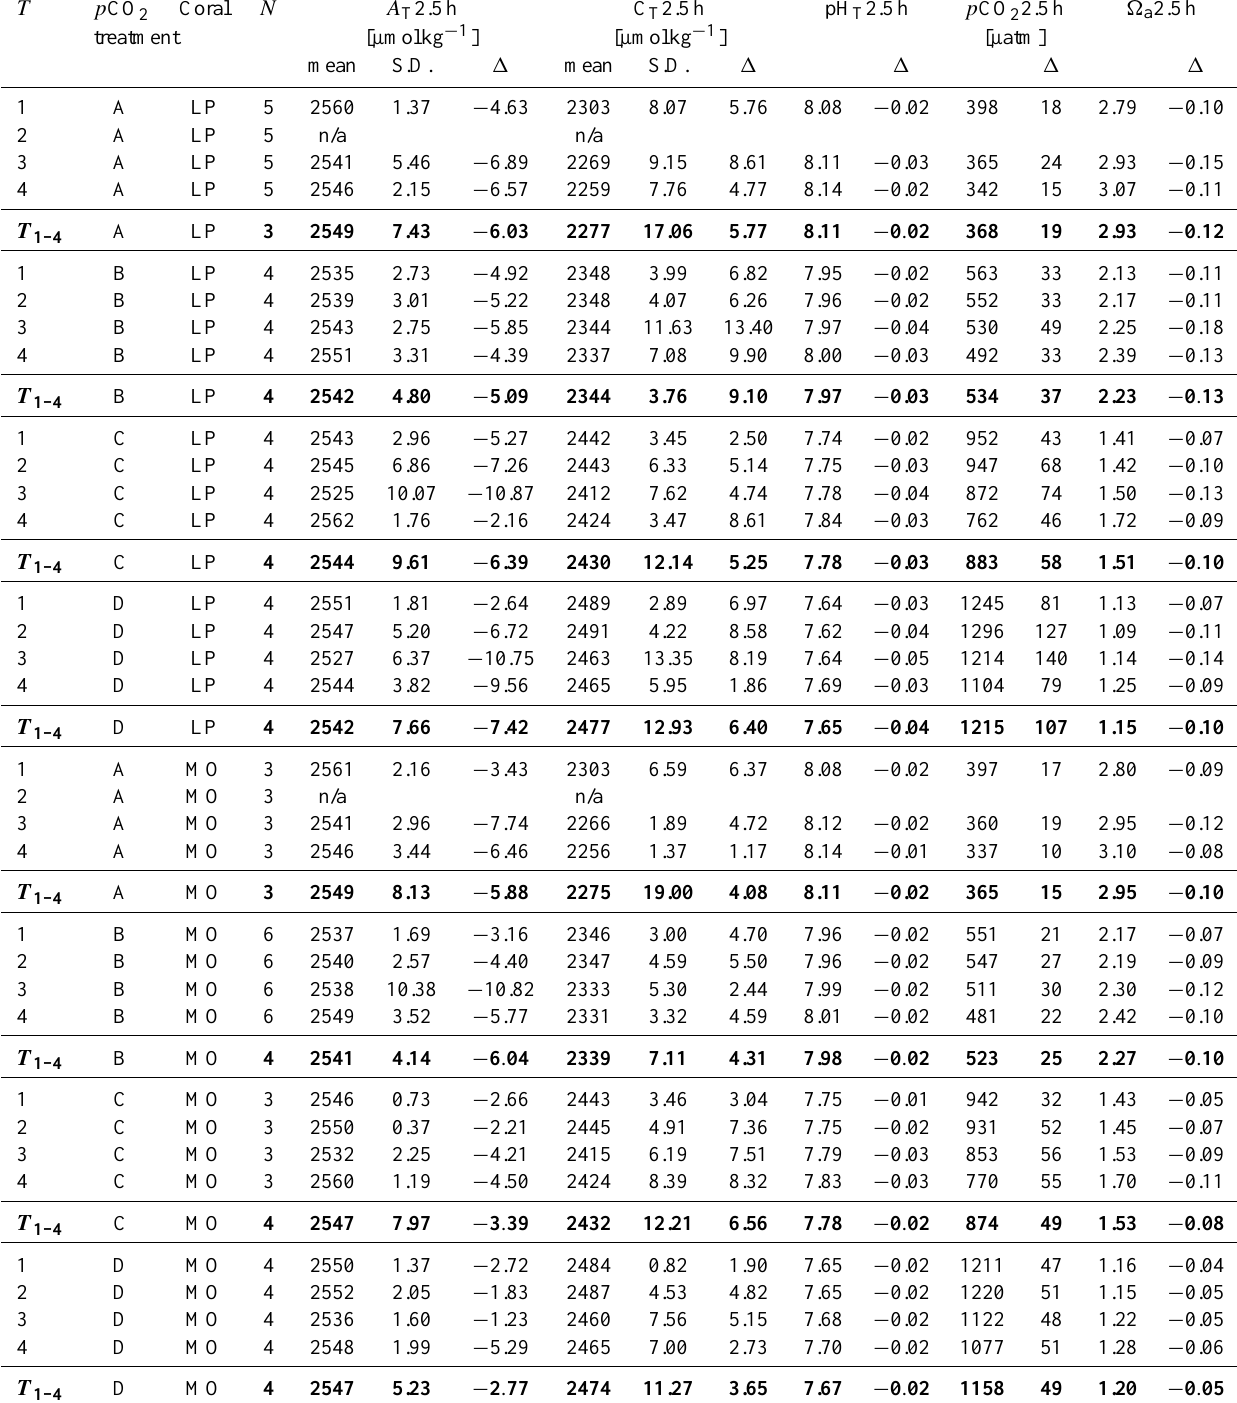
Table 3. Estimated parameters of the carbonate chemistry at the end of the incubations of coral fragments of L. pertusa (LP) and M. oculata (MO). Mean values A T 2 . 5h and C T 2 . 5h were used to calculate the other parameters of carbonate chemistry (pH T 2 . 5h, p CO 2 2 . 5h and (cid:127) a 2 . 5h). The difference between the end and the beginning of the incubations is also shown ( 1 ). T is the period at which the incubations were performed (at ca. monthly intervals). T 1 − 4 displays the pooled data for T 1 to T 4